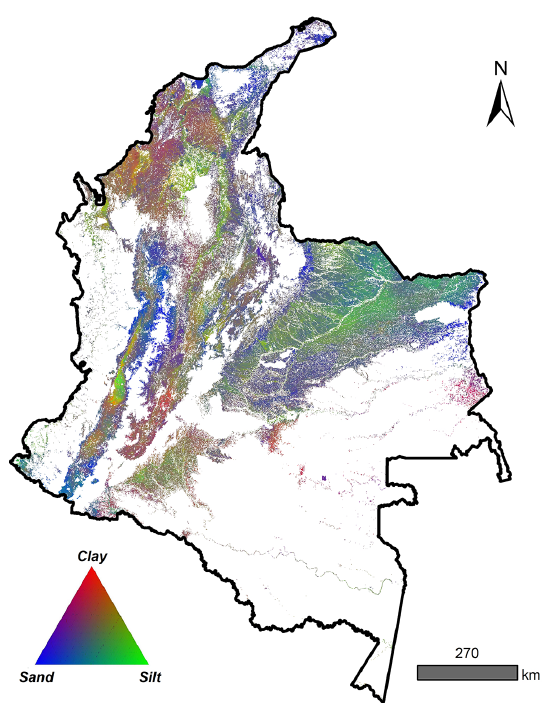
Figure B1. Compositional texture map (clay, sand, and silt), integrated from 0 to 100cm, in the agricultural frontier in Colombia.